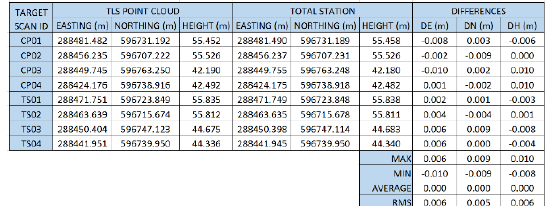
Table 6. Comparison between TLS point cloud data computed by ScanMaster software and Total Station data using